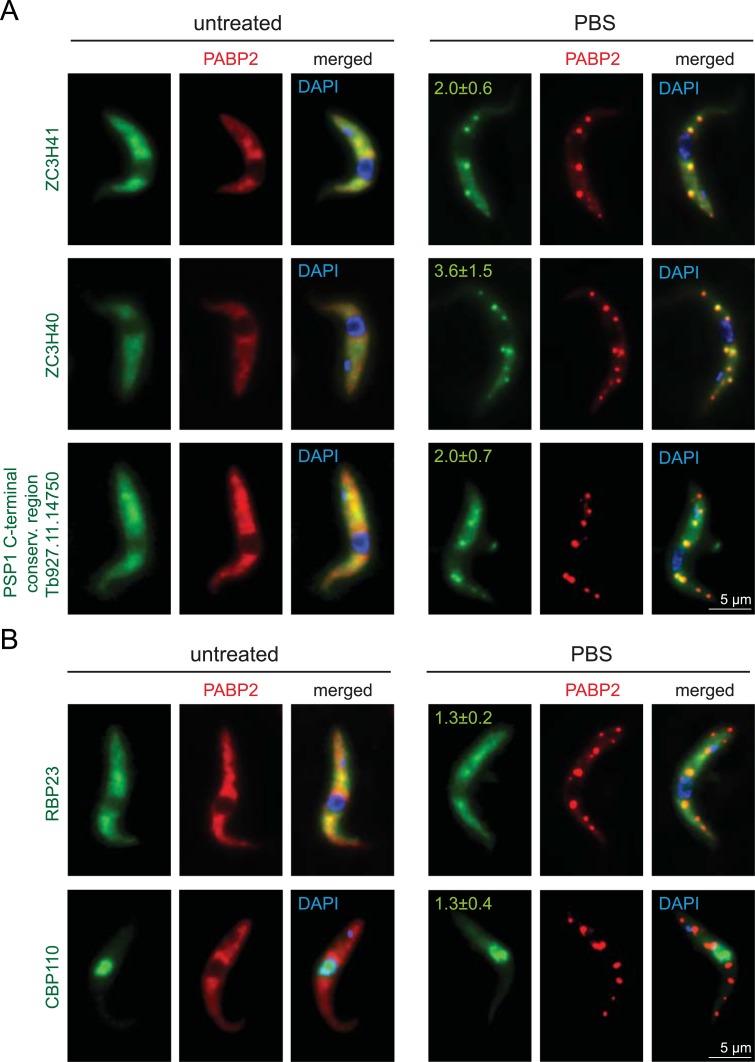
Localisation of PABP-interacting proteins to starvation stress granules.PABP interacting proteins were expressed as eYFP fusion proteins in a cell line expressing the starvation stress granule marker PABP2 as a C-terminal mChFP fusion. One representative Z-stack projection image is shown for untreated and starved parasites for proteins that localise to granules (A) and proteins that are (largely) absent from granules (B). For all PBS treated cells, the average stress granule enrichment ratio with standard deviation is shown on top of each image: Granules were defined on the mChFP image (PABP2) by threshold settings using the maximal entropy method of ImageJ (https://imagej.nih.gov/ij/) and the background corrected fluorescence within the granule divided by the background corrected fluorescence next to the granule was calculated for the three largest granules of ten cells for all five eYFP fusion proteins. Broad-field images of all cell lines are available in S1 Fig.